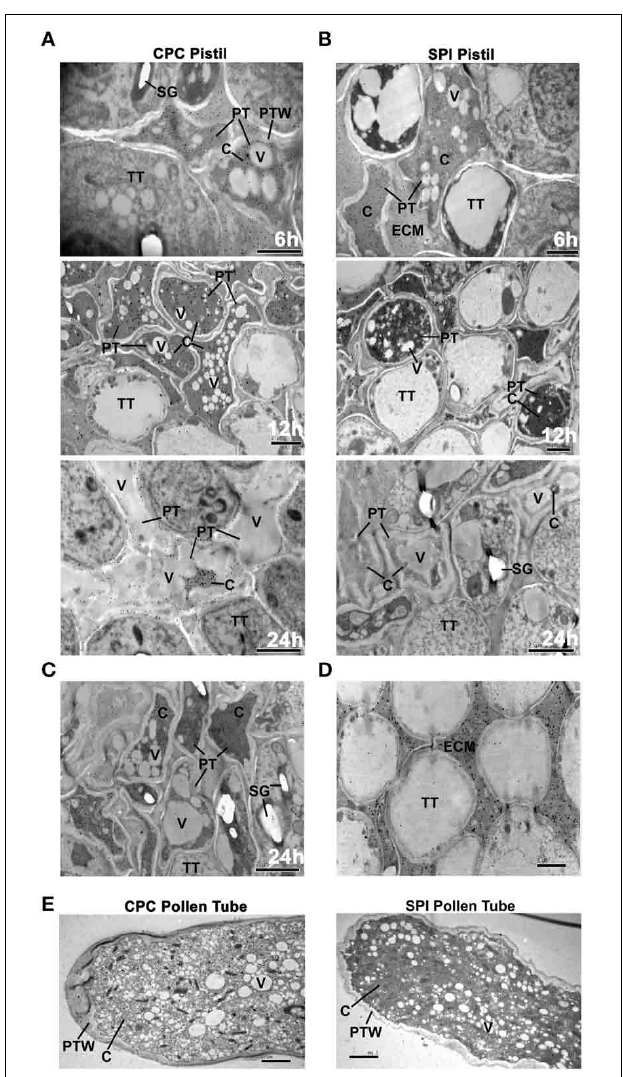
FIGURE 2 | S-RNases localize to the cytosol of both compatible and incompatible pollen tubes. (A) Immunogold labeling of PhS 3L -RNase in cross-sectioned pistils of 6, 12, and 24h post compatible pollination (CPC), respectively. A zone that is relatively close to the pollen tube tip was observed. (B) Immunogold labeling of PhS 3L -RNase in cross-sectioned pistils after 6, 12, and 24h post incompatible pollination (SPI), respectively. A zone that is relatively close to the pollen tube tip was observed. (C) Immunogold labeling of PhS 3L -RNase in cross-sectioned pistils after 24h post compatible pollination. A zone that is relatively close to the upper one-third pollen tube was observed. (D) A region without pollen tube showing PhS 3L -RNase accumulation mainly in ECM of a mature pistil as positive control. (E) Immunogold labeling of PhS 3L -RNase in in vitro germinated pollen tube of CPC ( S v ) and SPI ( S 3L ), respectively (longitudinal-section). PT, pollen tube; PTW, pollen tube wall; TT, transmitting tract tissue; C, cytosol; V, vacuole; SG, starch granule; ECM, extracellular